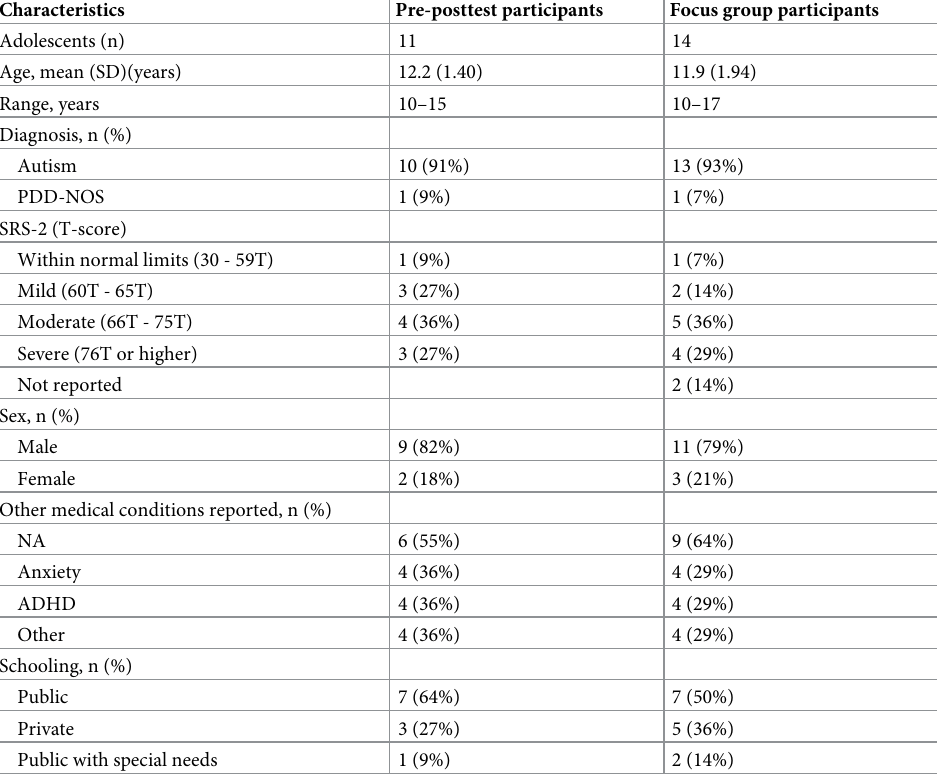
Table 2. Characteristics of adolescents who participated in technology clubs as reported by